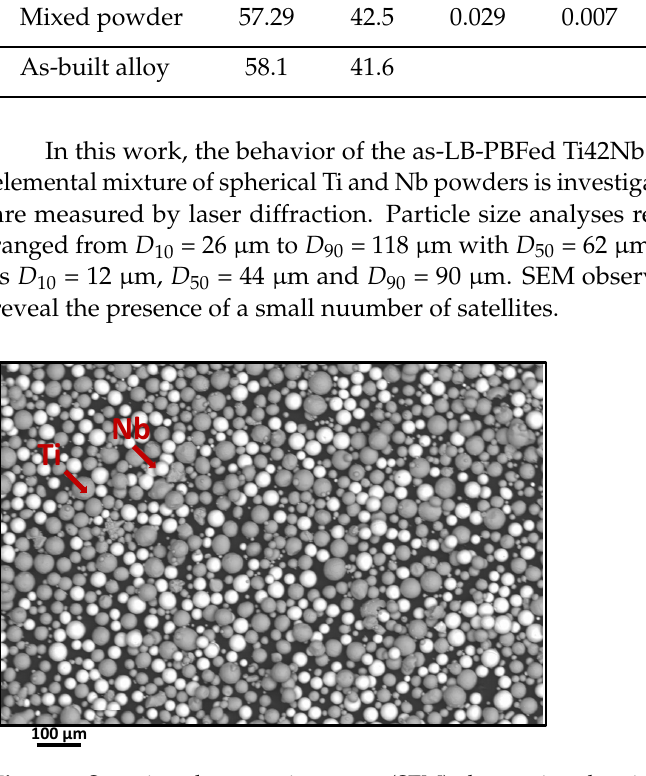
Figure 1. Scanning electron microscopy (SEM) observation showing the powder